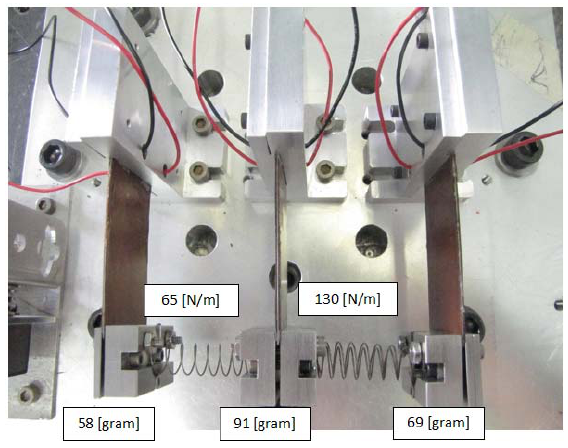
Figure 7. The three bimorphs system experimental setup—a zoomed view.